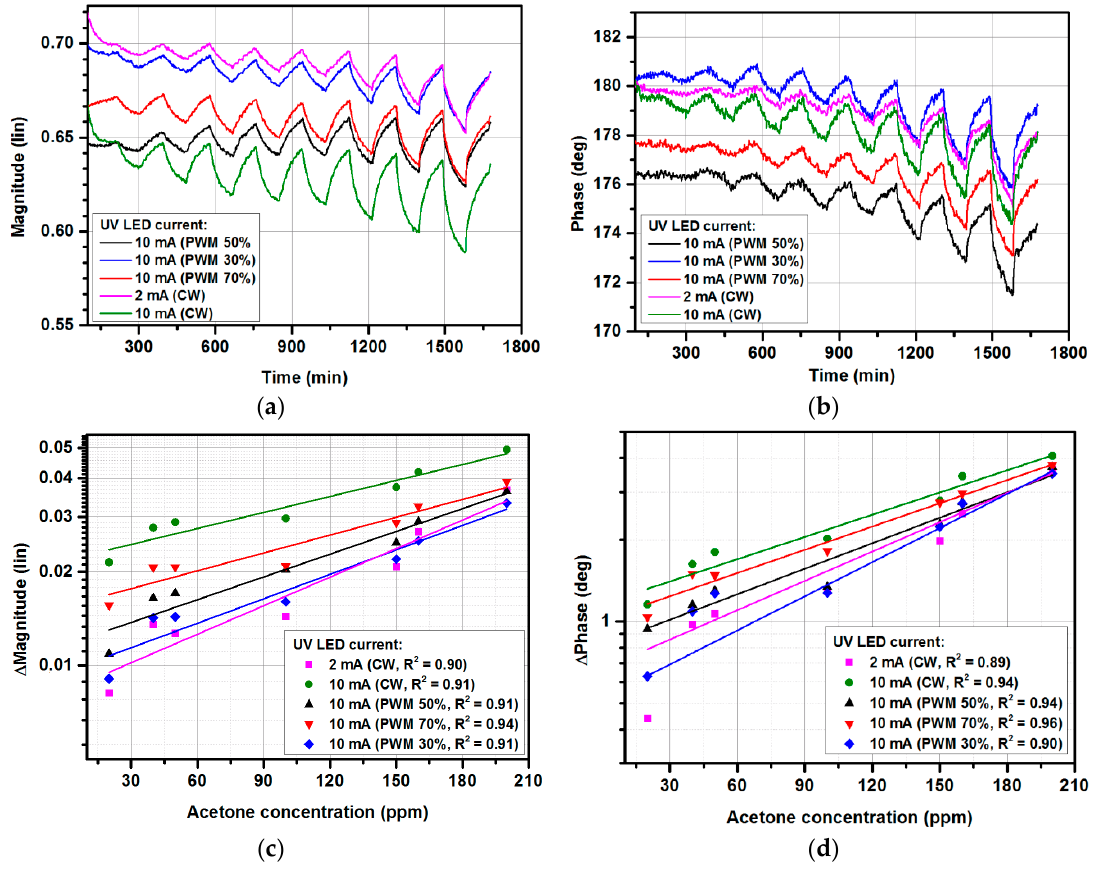
Figure 5. The gas-sensing characteristics under exposure to acetone in the 0–200 ppm range: ( a ) magnitude changes in time; ( b ) phase changes in time; ( c ) calibration curve for magnitude changes; ( d ) calibration curve for phase changes.